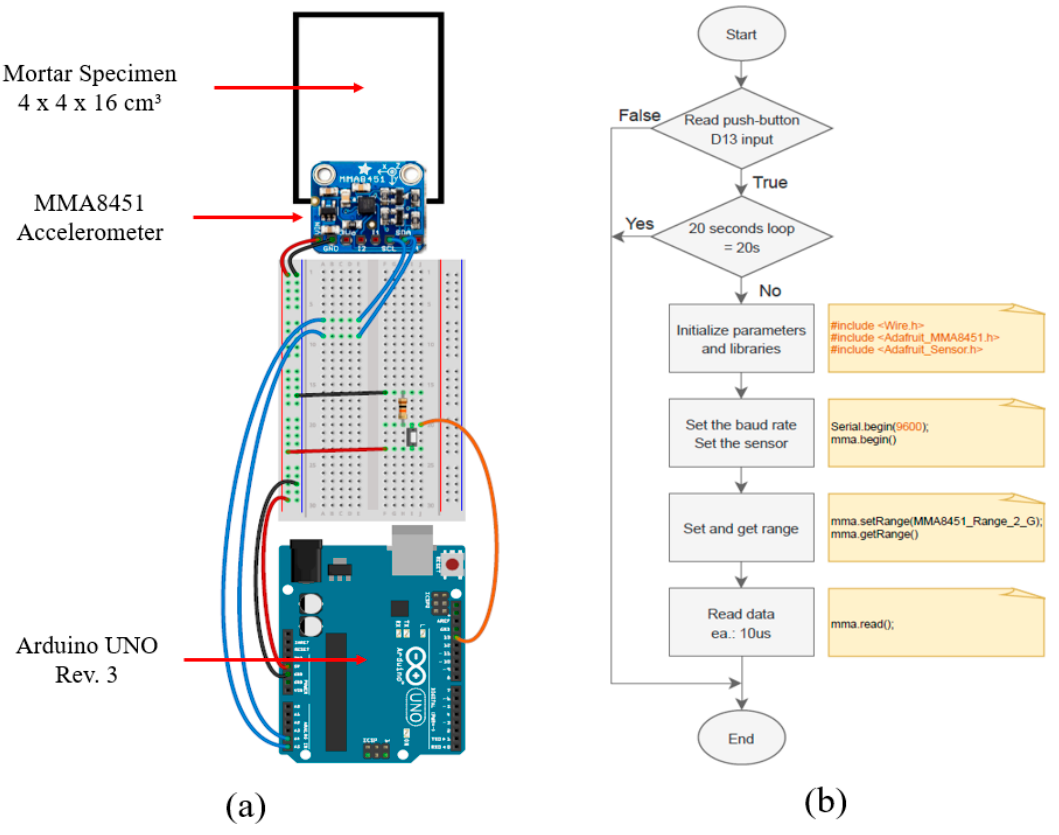
Figure 1. ( a ) Mounting diagram of the accelerometer used with Fritzing software; ( b ) simplified flow diagram of the programming carried out.